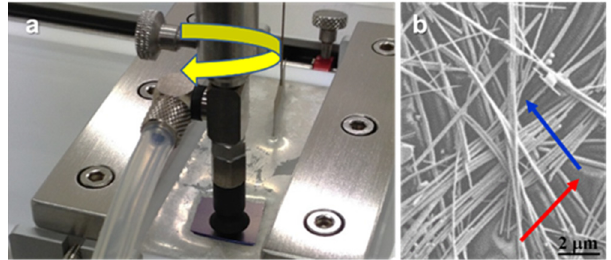
Figure 4. ( a ) Langmuir ‐ Schaefer deposition procedure. ( b ) FE ‐ SEM image of the C8 ‐ AgNW bilayer obtained by the Langmuir ‐ Schaefer (LS) methodology. Arrows indicate the orientation of the first (red), and second layers (blue).